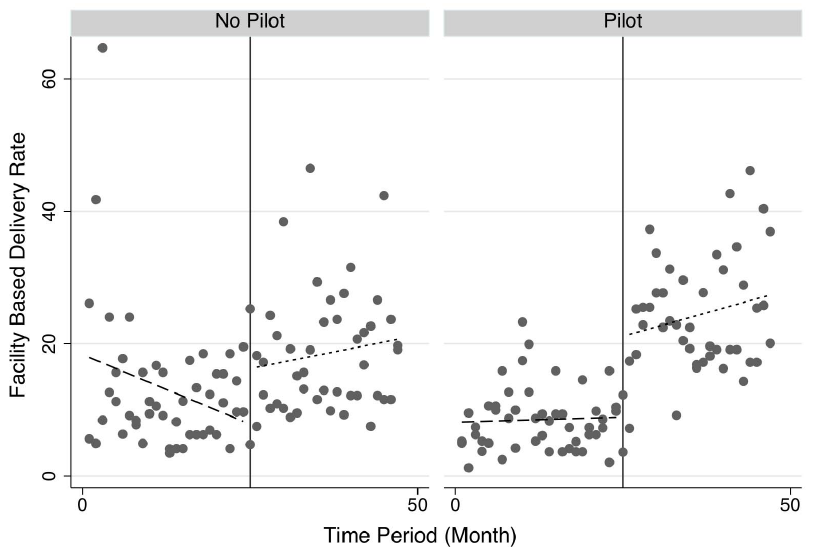
Figure 5. Facility Based Deliveries at Pilot (Nong and Thaphangthong) and Non-Pilot (Xonbouli and Vilabouli) Districts.